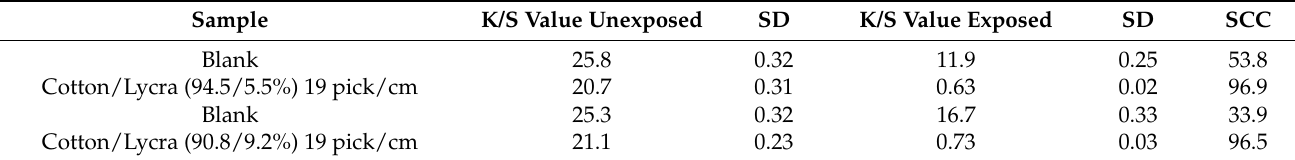
Table 5. Self-cleaning of the blank and SiO 2 -NP/cotton/lycra composite